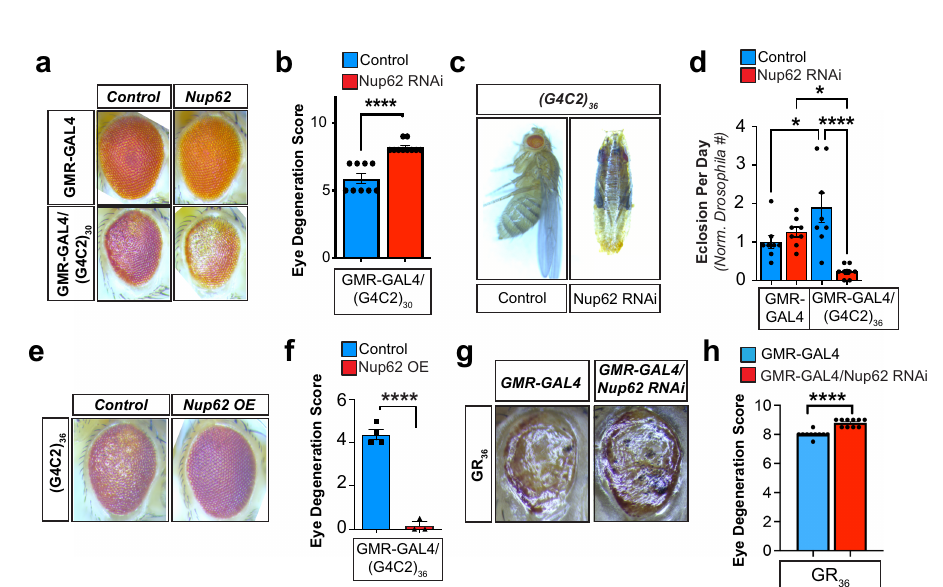
Fig. 5 Cytoplasmic NUP62 and TDP-43 colocalization promotes insolubility. a HEK293 cells were co-transfected with mRuby-NUP62 and eGFP-TDP-43 (wild type). The cells were observed through live-scan confocal microscopy starting 3 h after transfection and images were obtained every 5 min over the course of 15 h. Two populations of cytoplasmic mRuby-NUP62 condensates were observed: reversible or irreversible. Reversible structures exhibit more dynamic activity and appear circular (see arrow). Irreversible structures appear less mobile or more static and have an angular structure (see asterisks). b Schematic depicting characteristics of cytoplasmic mRuby-NUP62 structures is shown at bottom. Representative still images were obtained from the 6 – 10 h time points of the imaging session. c Quanti fi cation of NUP62 area in confocal microscopy images obtained during live imaging (5 – 15 h timepoints) described in Fig. 5A, B. Irreversible condensates were signi fi cantly larger than reversible structures. The size of reversible granules was determined at times point immediately prior to dissipation. Irreversible granule area was calculated at fi nal time point collected during live imaging session. n = 50 (reversible), 20 (irreversible) NUP62 + granules. Statistical signi fi cance was determined by two-tailed, unpaired student ’ s t-test. Data are shown as mean + /- SEM. d The percentage of reversible and irreversible mRuby-NUP62 granules containing eGFP-TDP-43 were calculated for each frame taken throughout the duration of living imaging session (5 – 15 h timepoints) described in Fig. 5a, b. A greater percentage of irreversible mRuby-NUP62 condensates contained eGFP-TDP43. n = 12 frames per group. Statistical signi fi cance was determined by two-tailed, unpaired student ’ s t-test. Data are shown as mean + /- SEM. e mRuby-NUP62 condensates were characterized for circularity score at the fi nal time point of live image session (5 – 15 h timepoints) described in Fig. 5a, b. Irreversible mRuby-NUP62 + eGFP-TDP-43 + condensates ( n = 26 condensates) had a signi fi cantly reduced circularity score relative to eGFP-TDP-43 - ( n = 17 condensates) and reversible mRuby-NUP62 + eGFP-TDP-43 + condensates ( n = 12 condensates). Statistically differences were calculated by one- way ANOVA with Tukey post hoc analysis. Data are shown as mean + /- SEM. f Representative FRAP analysis images of nuclear eGFP-TDP-43 (reference solubility control) and cytoplasmic eGFP-TDP-43 and mRuby-NUP62 condensates. g Quanti fi cation of FRAP analysis shows reduced fl uorescence signal recovery in cytoplasmic eGFP-TDP-43 and mRuby-NUP62 condensates relative to nuclear eGFP-TDP-43 control. Data are shown as mean + /- SD. h HEK293 cells were transfected with indicated plasmids for 24 h. Soluble and insoluble biochemical fractionation was then conducted, and Western blot analysis was performed to evaluate TDP-43 and GAPDH (protein loading control). mRuby-NUP62 promotes the formation of increased insoluble TDP-43. Representative western blot image is shown. i HEK293 cells were transfected with mRuby-NUP62 and eGFP-TDP-43 (WT or Δ NLS) for 24 h. Samples were then immunoprecipitated by ChromoTek GFP-Trap Magnetic Agarose af fi nity beads. Samples were then immunoblotted for NUP62 and TDP-43.